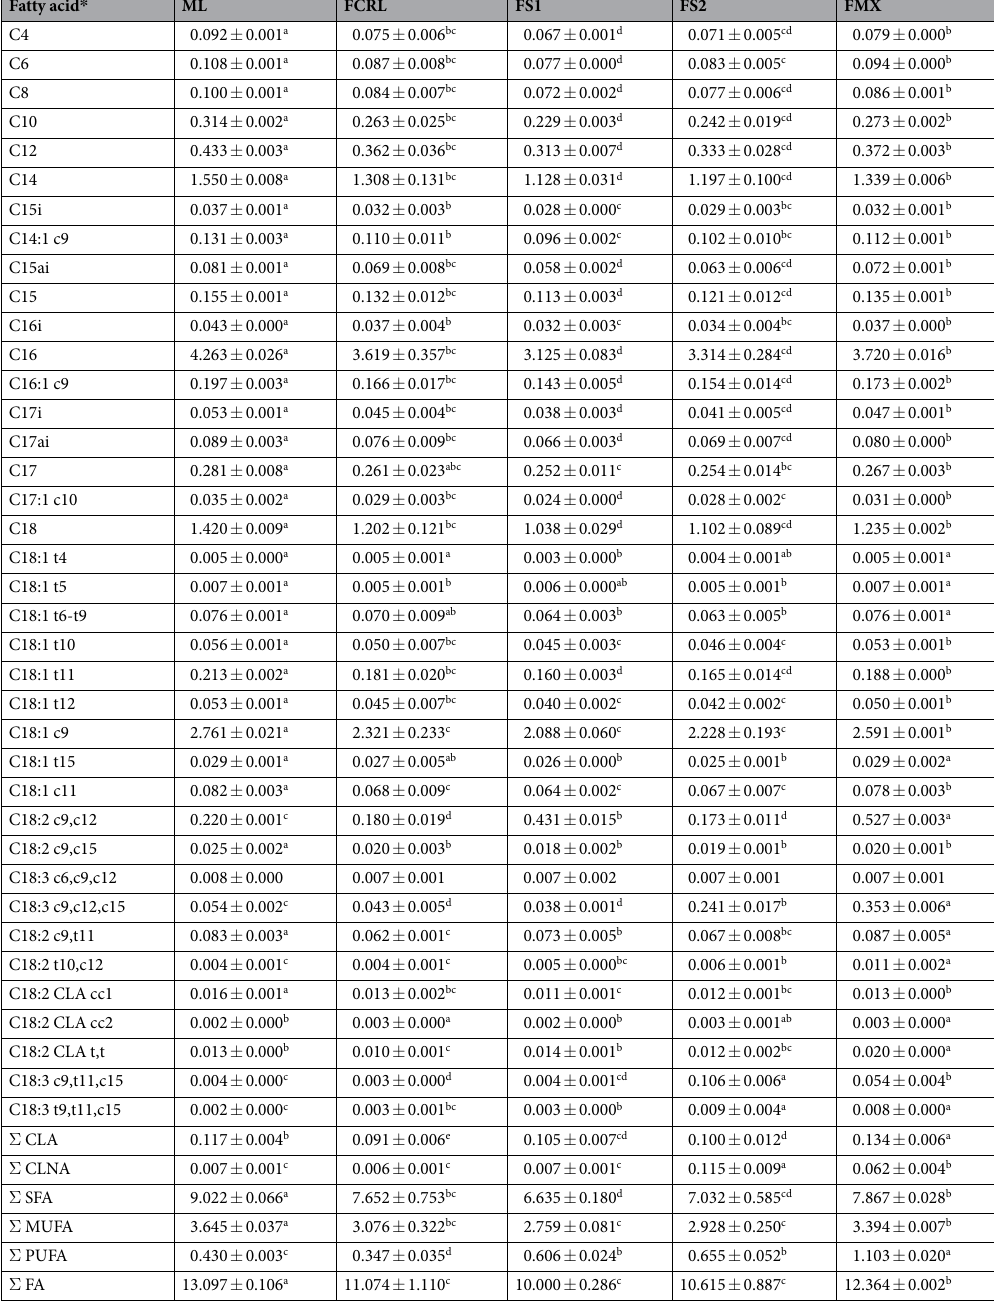
Table 2. Fatty acid composition (mg/mL) of semi-skimmed UHT milk (ML) and semi-skimmed fermented UHT milk prepared with B. breve NCIMB 702258 upon 24 h incubation in the absence (FCRL) and presence of either 0.5 mg/mL of LA (FS1), α -LNA (FS2) or both substrates (1:1; FMX). * Average value ± standard deviation (n = 3). a,b,c,d,e Different superscript letters within a row for significant differences (p < 0.05). c = cis double bound; t = trans double bound; ∑ = total; CLA = conjugated linoleic acid; CLNA = conjugated linolenic acid; SFA = saturated fatty acids; MUFA = monounsaturated fatty acids; PUFA = polyunsaturated fatty acids; FA = fatty acids. ML: commercial skimmed milk, FCRL: fermented milk by B. breve NCIMB 702258; FS1: fermented milk with LA added; FS2: fermented milk with α -LNA added; FS3: fermented milk with LA and α -LNA